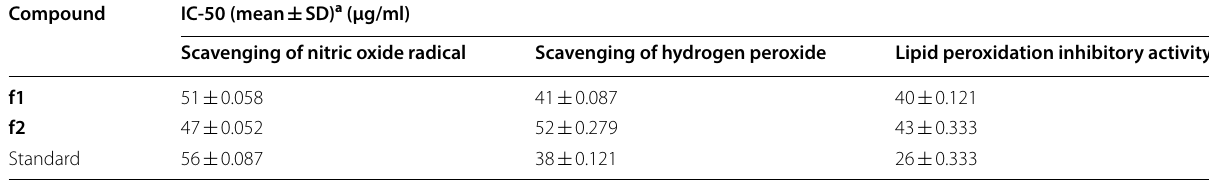
Table 44 Antioxidant activity (IC-50 values) of compounds f1 and f2